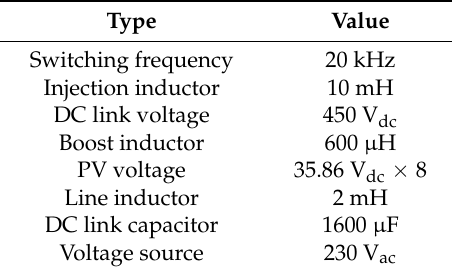
Table 2. Parameters and components for PV